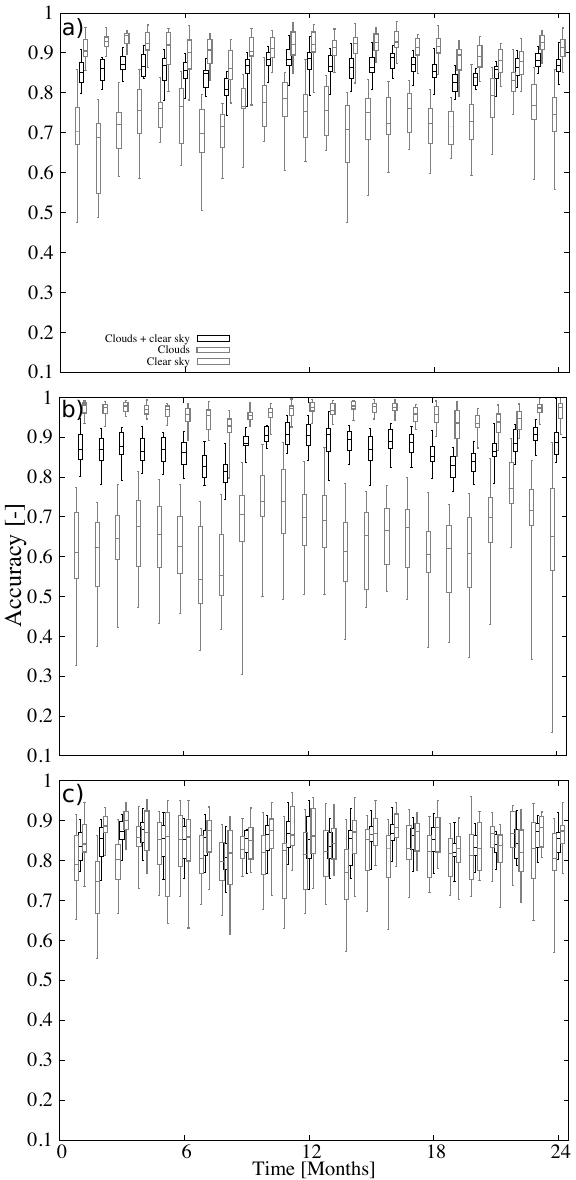
Figure 6. Box and whiskers plots of the daily accuracy on a motnthly basis for ( a ) all retrievals, ( b ) daytime retrievals, and ( c ) nighttime retrievals. The middle bar indicates the median, the lower (upper) bases of the boxes are the 25 (75) percentiles, and the lower (upper) whiskers indicate the 5 (95) percentiles. The accuracy for all-sky conditions, cloud detection, and clear sky detection are shown (see